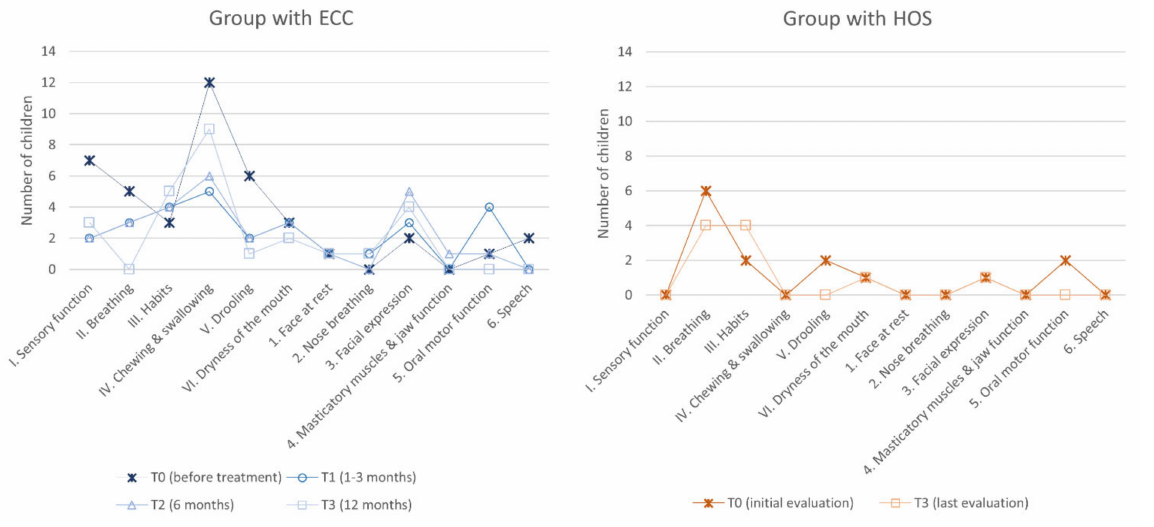
Figure 2. Domain-by-domain orofacial dysfunction frequency throughout the study in both groups of